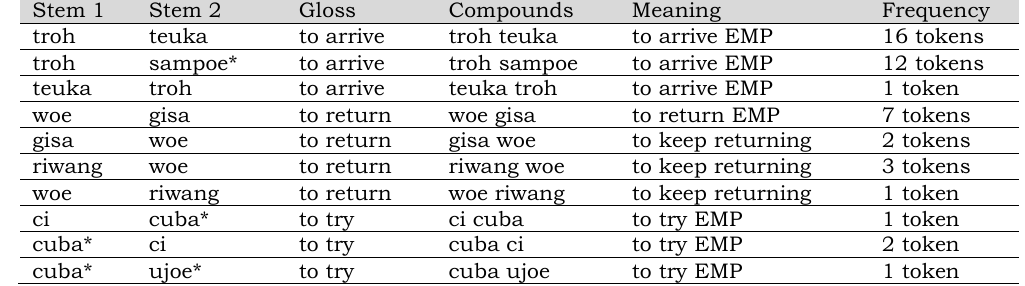
Table 1. Synonym compounds in